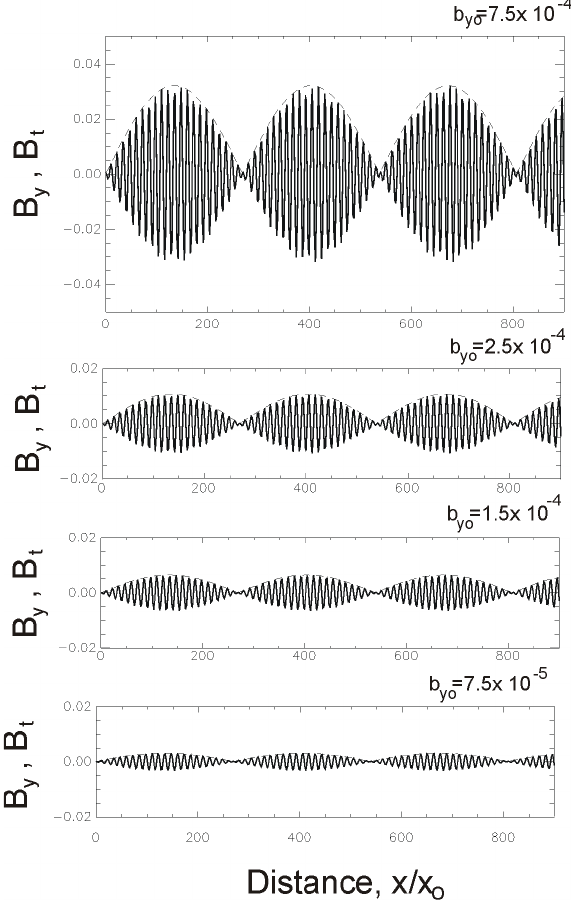
Fig. 12. Amplitude of periodic wave packets is proportional to the “initial” triggering perturbations.